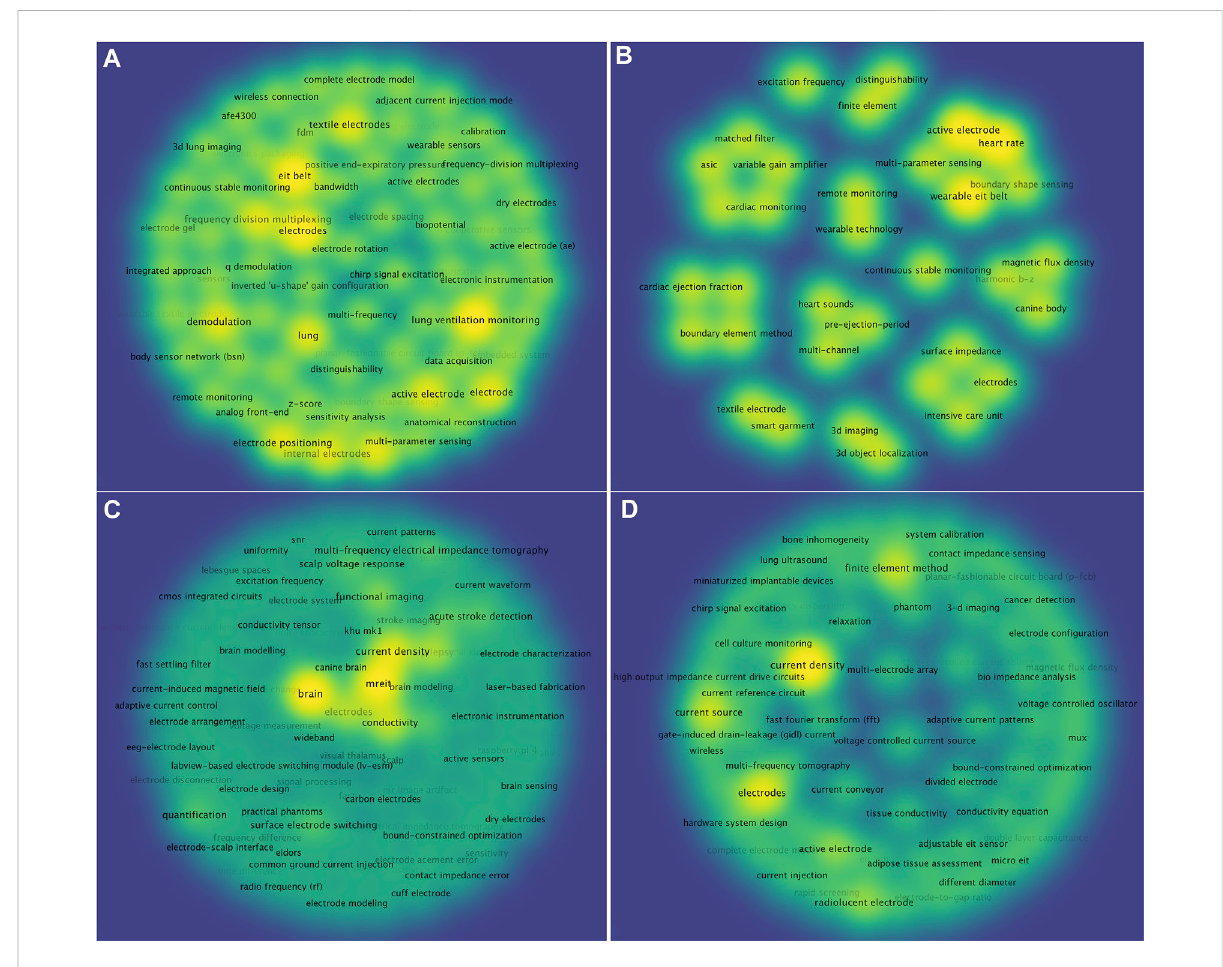
FIGURE 6 Keywords of EIT hardware research in speci fi c applications as “ pulmonary ” (A) “ hemodynamics ” (B) , “ tumor and tissue ” (C) and “ brain ” (D) . The label indicated keywords, the reduced color from yellow green indicated density of each keyword calculated by frequency of co-occurrence.